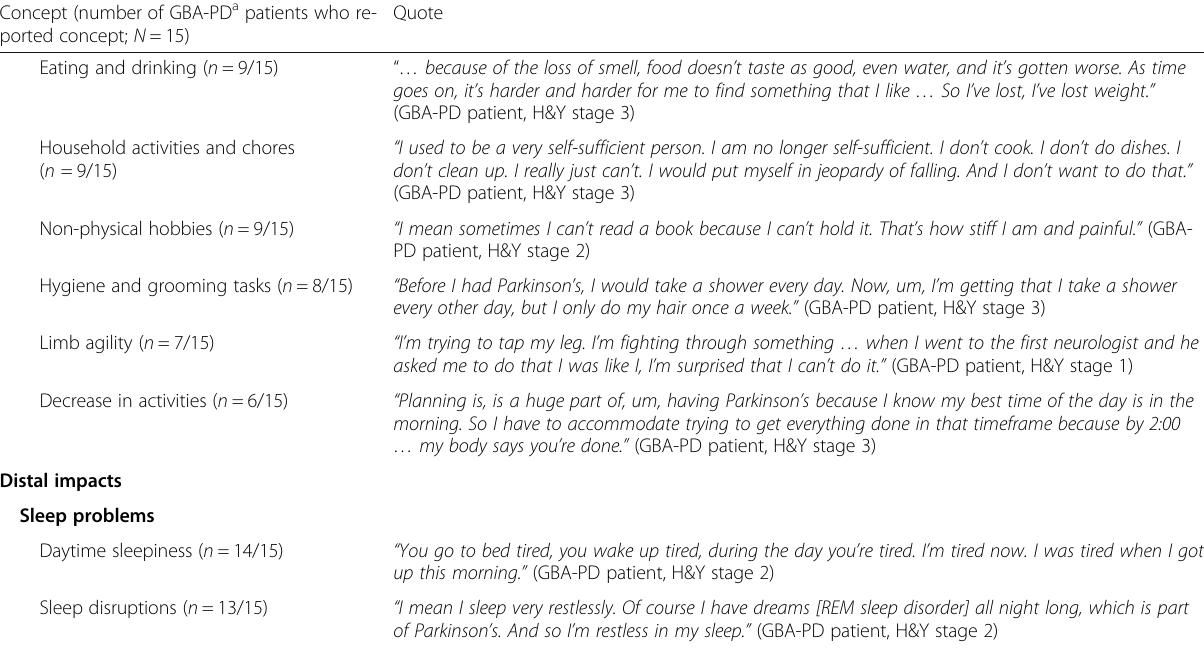
Table 4 Summary of symptom and proximal impact concepts reported by ≥ 5 GBA-PD a participants (Continued) Concept (number of GBA-PD a patients who re- ported concept; N =